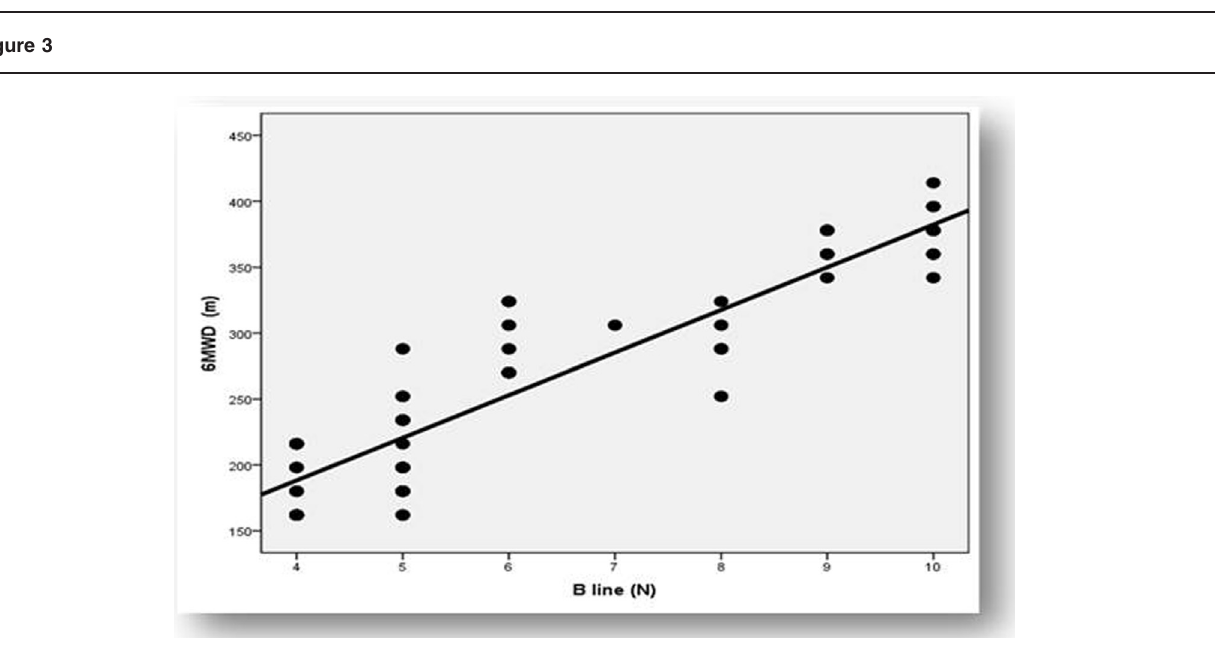
The relation between B-line number and 6-minute walk test